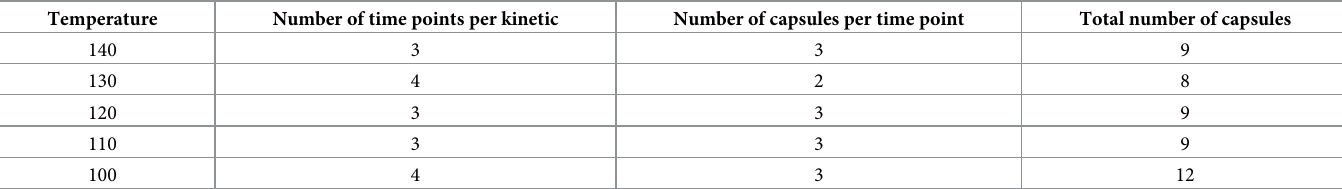
Table 1. Number of capsules used for each temperature and time point.